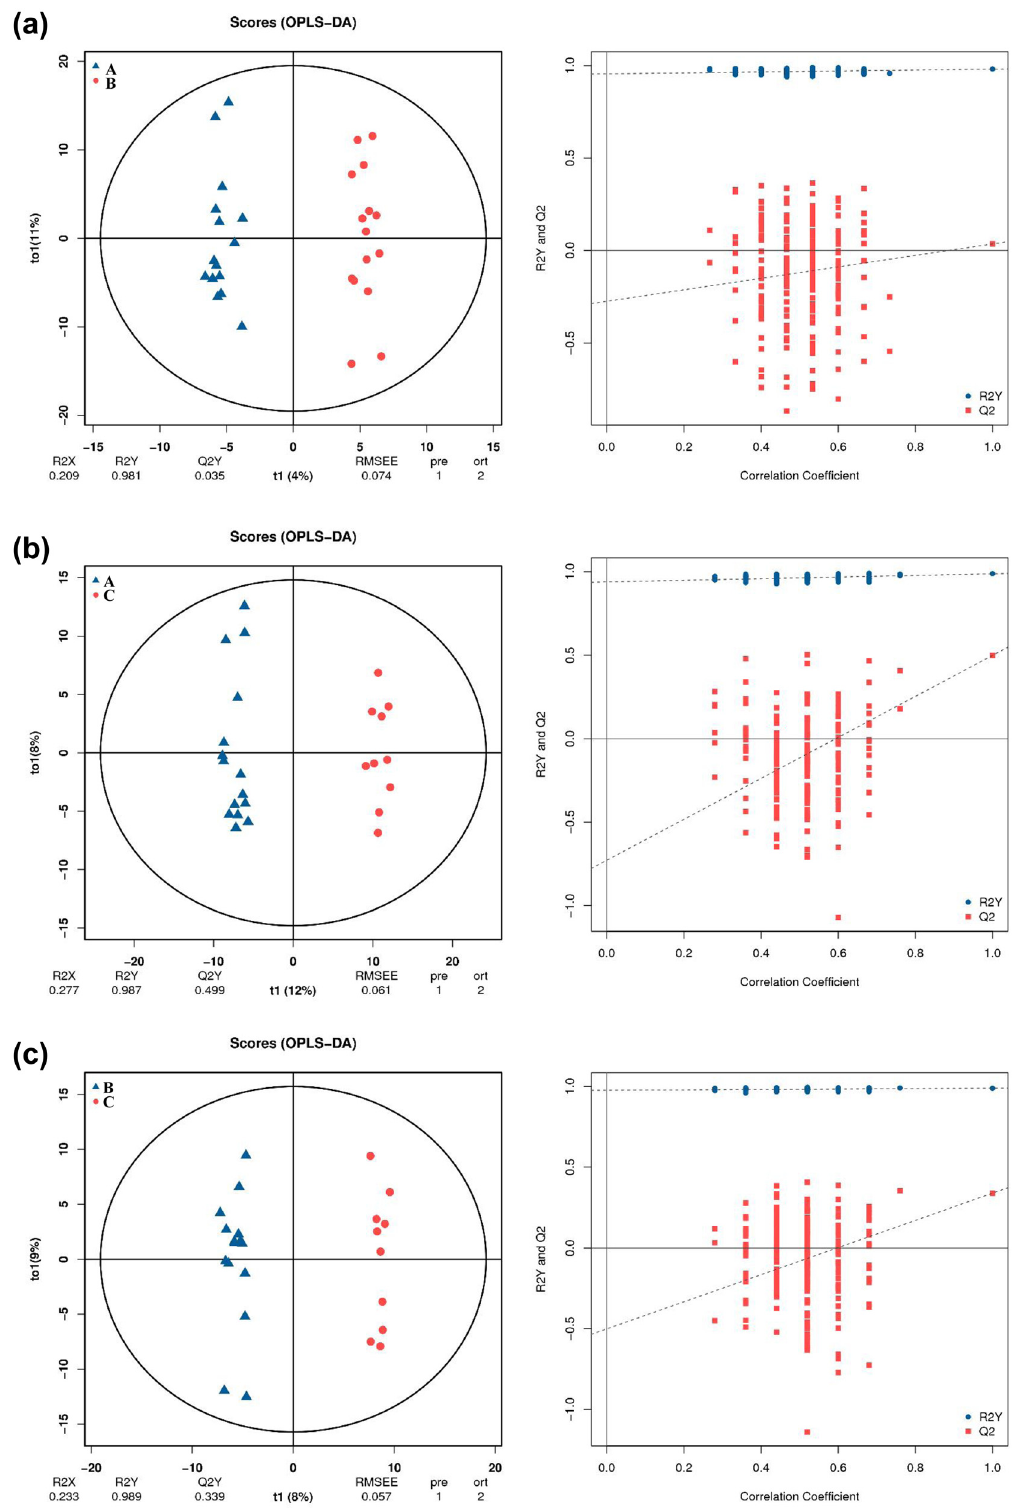
Figure 2: OPLS - DA score plots and OPLS - DA permutation test of serum metabolic pro fi ling. ( a ) OPLS - DA score plots and OPLS - DA permu - tation test in B vs A. ( b ) OPLS - DA score plots and OPLS - DA permutation test in C vs A. ( c ) OPLS - DA score plots and OPLS - DA permutation test in C vs